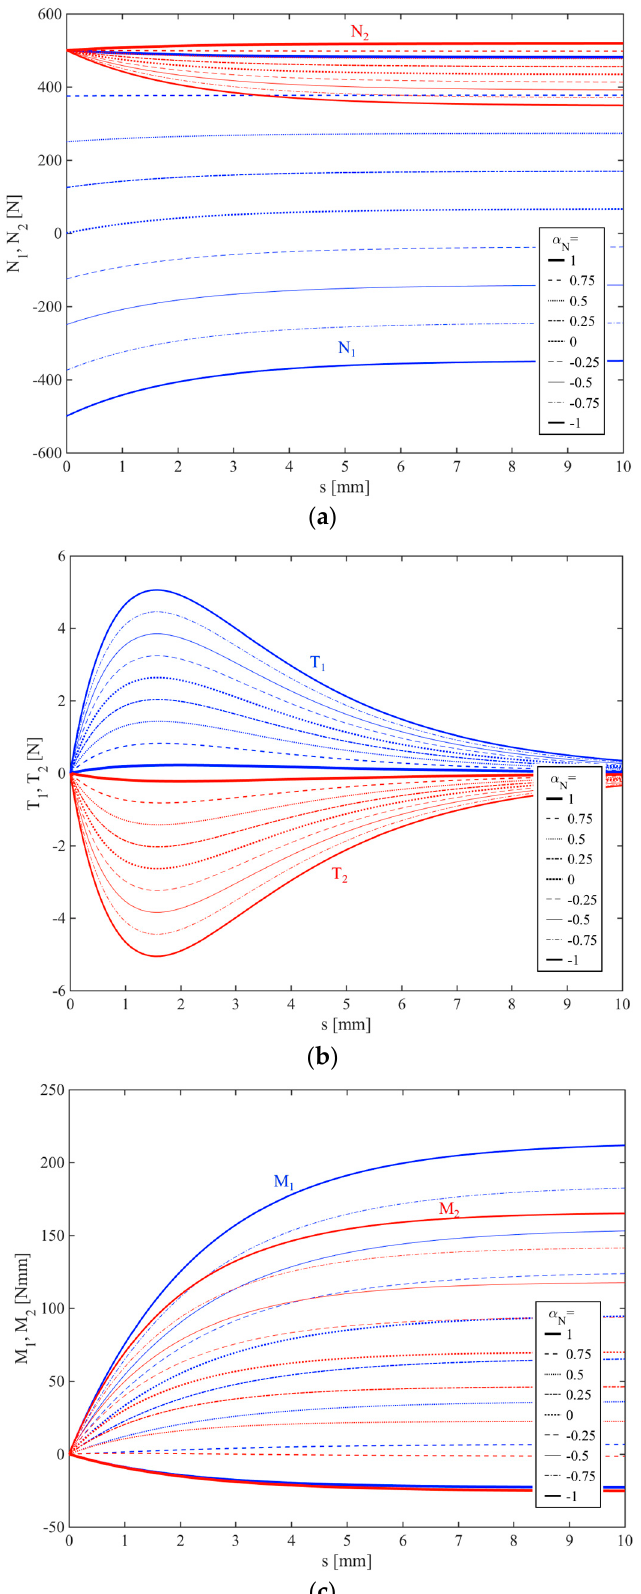
Figure 9. Effect of the axial loading on the static response of the sublaminates: ( a ) Axial force; ( b ) Shear force; ( c ) Bending moment. (Orthotropic specimen).